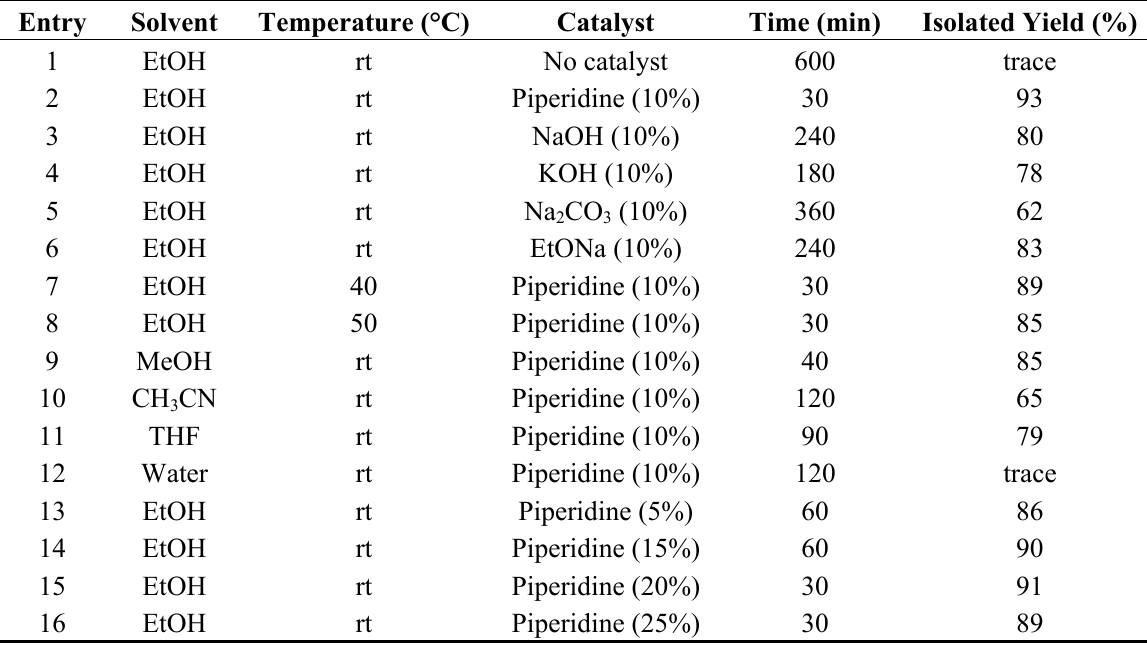
Table 1. Optimization of reaction conditions a